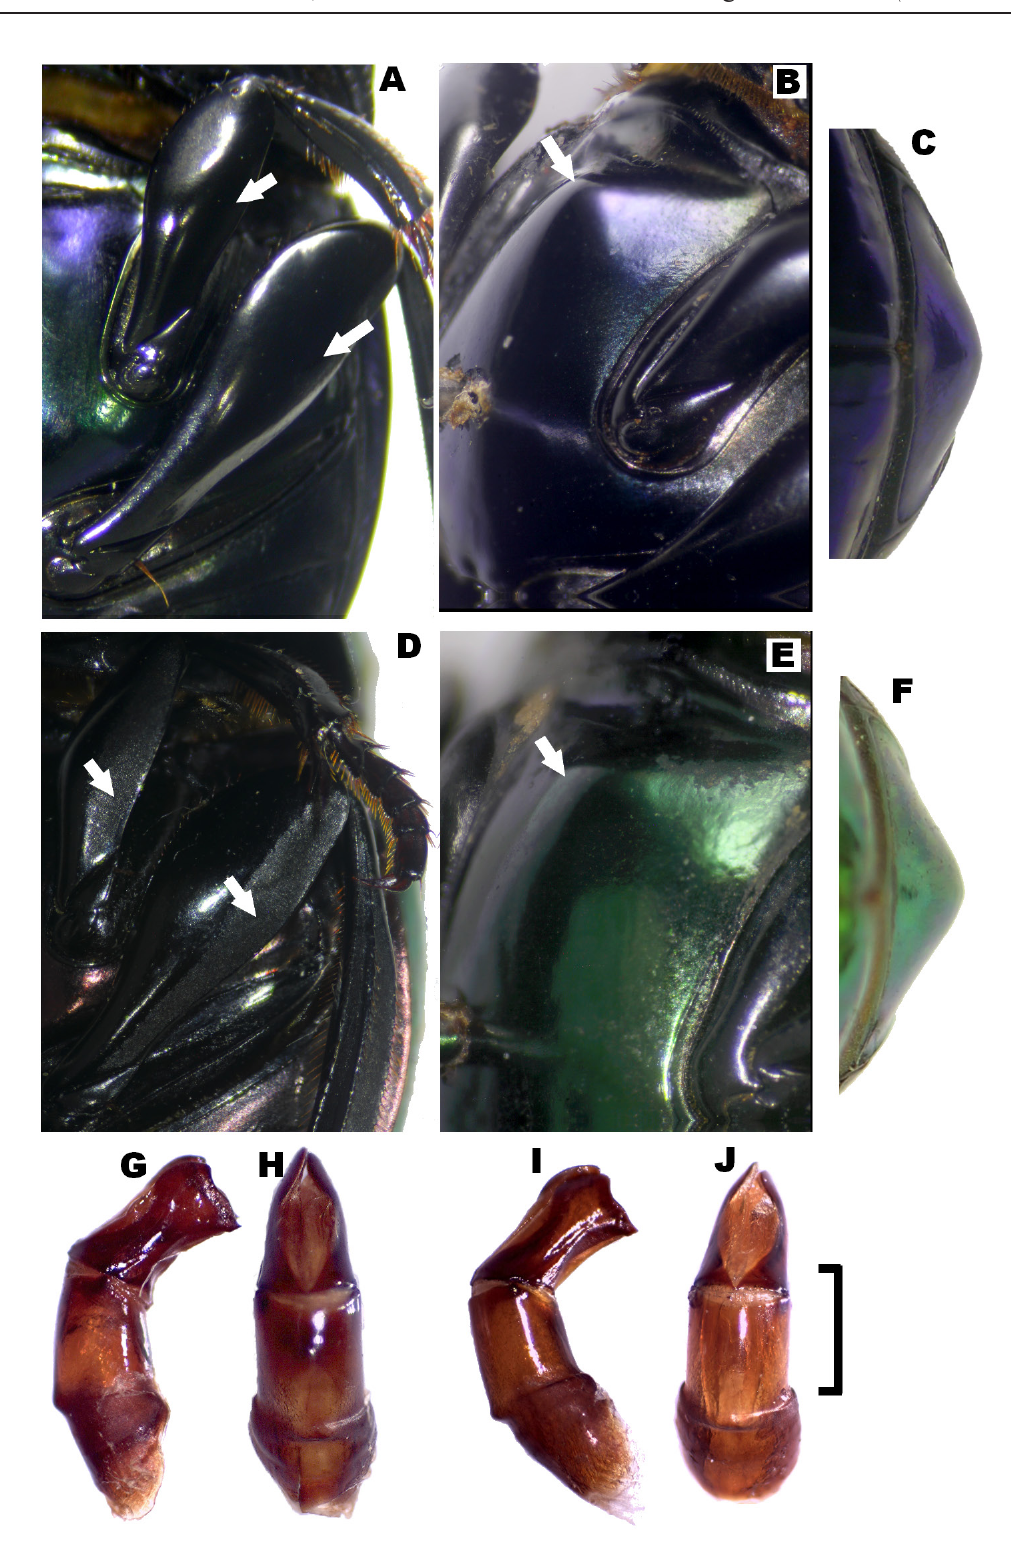
Fig. 1. A–C, G–H . Canthon (G.) smaragdulus smaragdulus (Fabricius, 1781). – D–F, I–J . Canthon (G.) fulgidus fulgidus Redtenbacher, 1868. A, D . Ventral surface of meso- and metafemora. B, E . Metasternal anterior lobe convex. C, F . Dorsal view showing convex pygidium. G, I . Paramera lateral view. H, J. Paramera dorsal view. Scale bar: